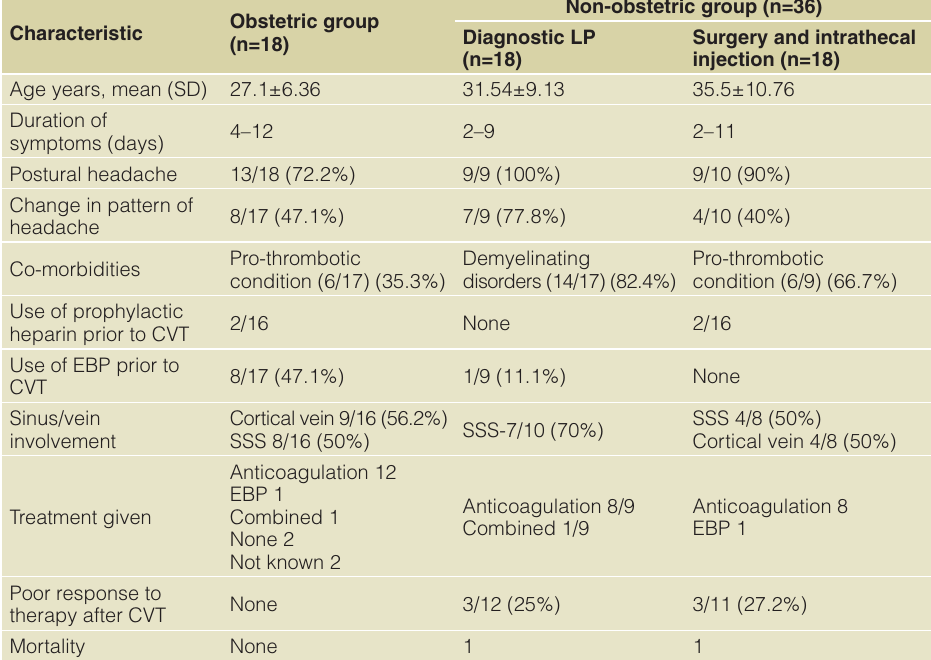
Table 1. Patient characteristics of the post-lumbar puncture intracranial hypotension and cerebral venous thrombosis (literature